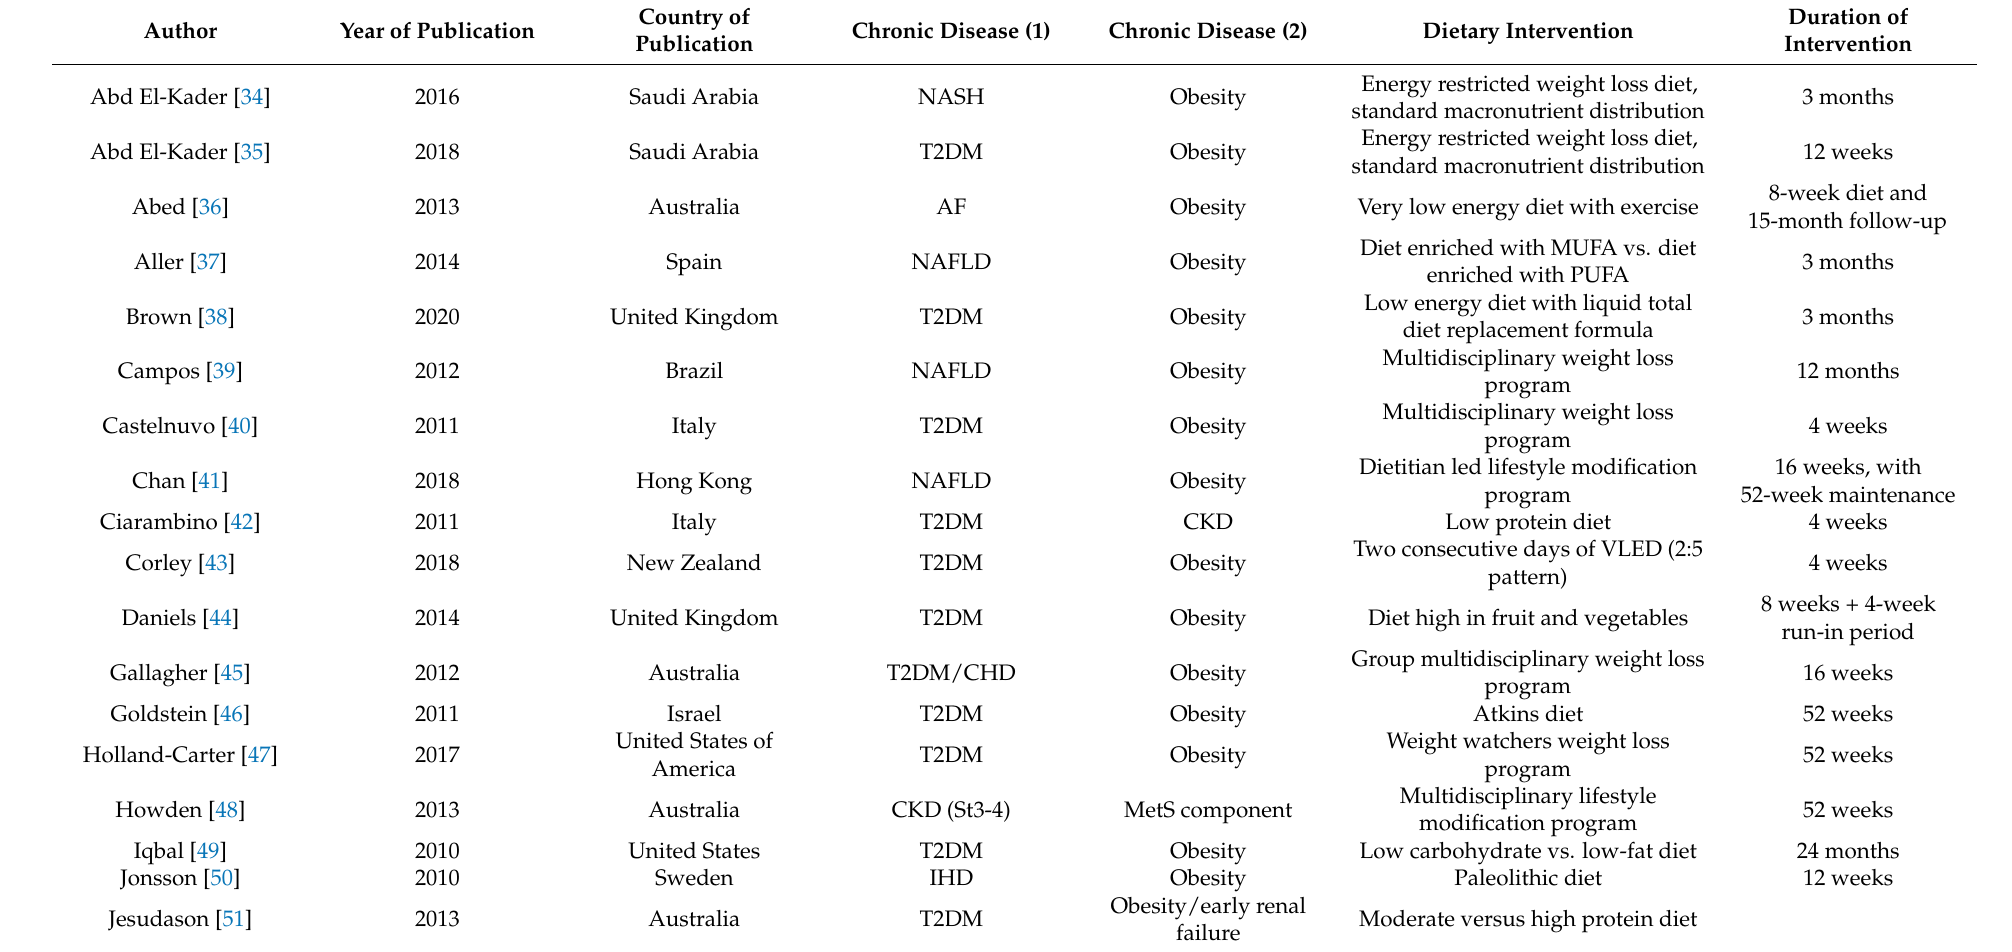
Table 1. Randomised controlled trials for nutritional management of complex chronic disease (arranged alphabetically by author